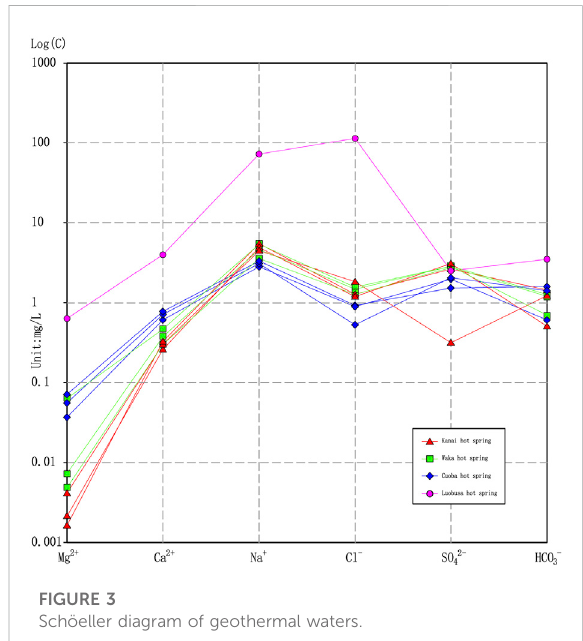
FIGURE 3 Schöeller diagram of geothermal